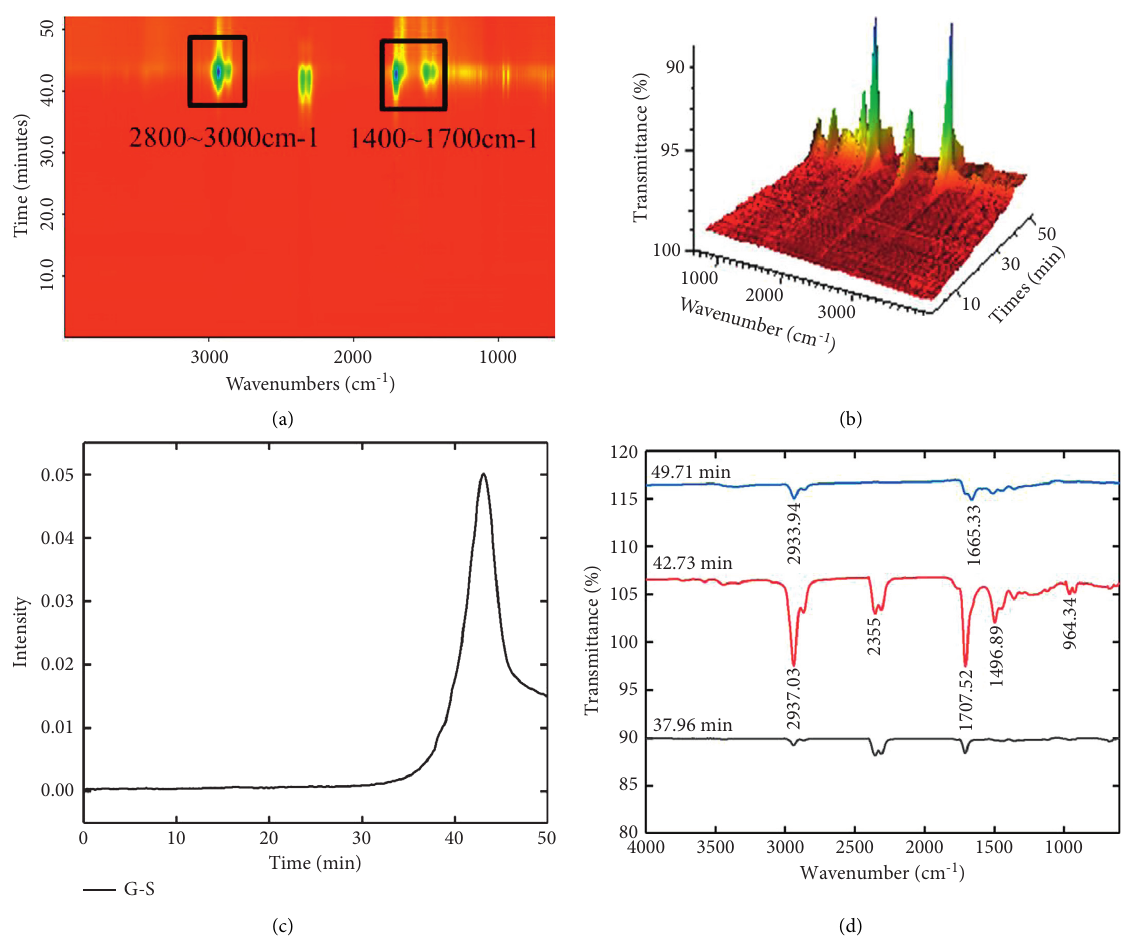
Figure 5: Dynamic FTIR testing results of the PA6 modifier.